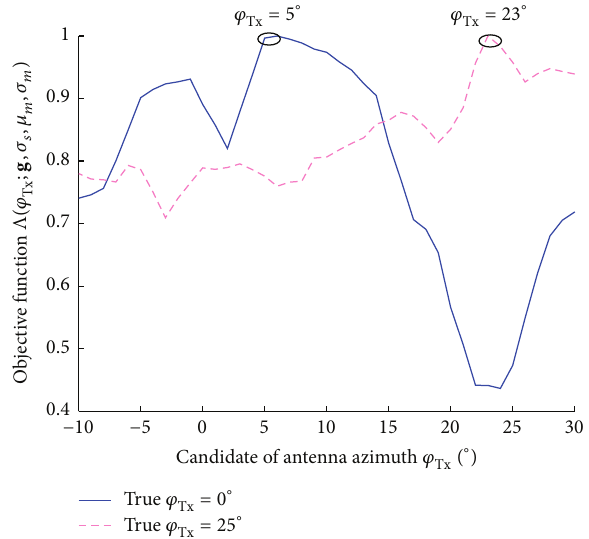
Figure 18: The objective functions calculated in the CFE method = 0 ∘ and 25 ∘ , with true 𝜑 Tx